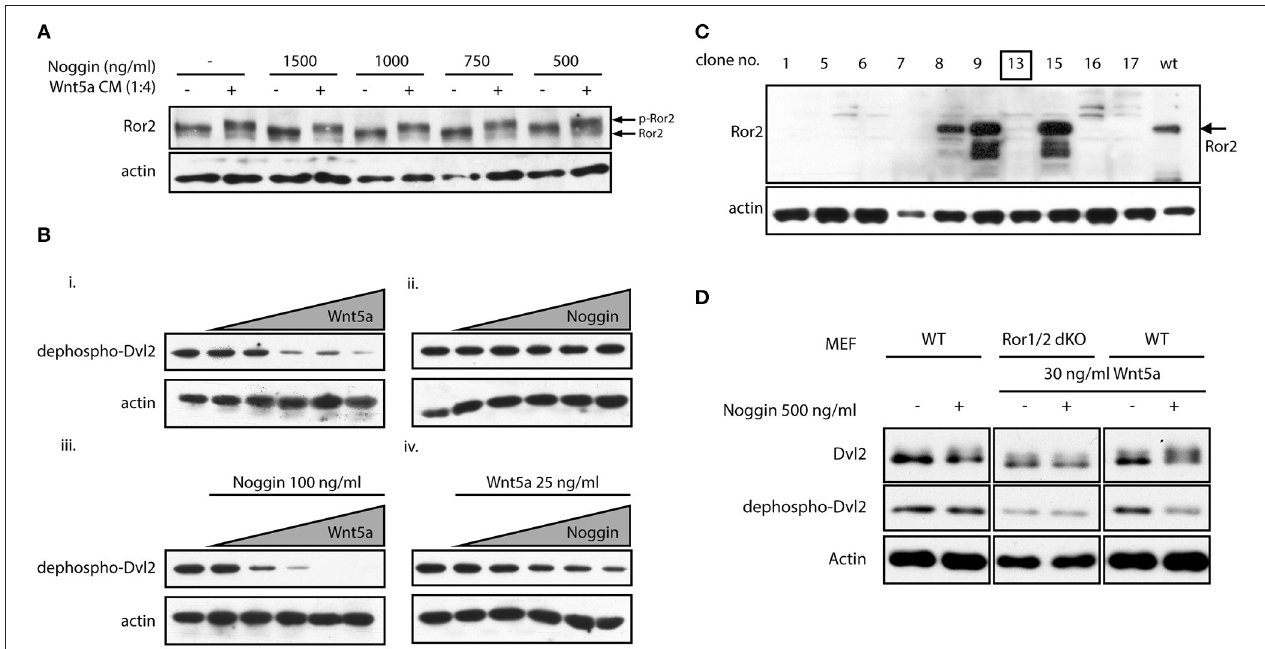
FIGURE 2 | Noggin potentiates Wnt/PCP signaling. (A) MEF cells were treated by Wnt-5a conditioned medium (CM) and stimulated by increasing doses of Noggin protein. Activation of Ror2 was analyzed as a phosphorylation-dependent shift by Western blotting. Noggin alone, in contrast to Wnt-5a CM, is not able to trigger activation of Ror2. (B) MEF cells were treated with increasing doses of Wnt-5a (0, 25, 50, 100, 150, and 200 ng/ml) and Noggin (0, 25, 50, 100, 150, and 200 ng/ml) for 2 h. The activation of Wnt signaling was assessed by Western blotting as a decrease in the signal of dephospho-Dvl2. Wnt-5a could cause phosphorylation of Dvl2 visible as a disappearance of dephospho-Dvl2 signal (i) , whereas Noggin is inactive in the same assay (ii) . Interestingly, pre-treatment of MEF cells by Noggin (100 ng/ml) enhanced the effect of Wnt-5a (iii) . On the other hand, Noggin, in a dose-dependent manner, potentiated the response to suboptimal doses of Wnt-5a (25 ng/ml), which are otherwise ineffective—see lane 2 in panel “i” (iv) . Actin is used as a loading control. (C) Ror1 flox / flox ; Ror2 flox / flox MEF cells were treated by tamoxifen and Ror1 − / − ; Ror2 − / − isogenic MEF line was isolated by serial dilutions method. The presence of Ror2 was tested by Western blotting and the clone no. 13 used for further studies is indicated. (D) MEF wt and MEF Ror1 − / − ; Ror2 − / − (Ror1/2 dKO) cells were treated by combinations of Noggin and Wnt-5a as indicated. Noggin itself cannot stimulate activation of Dvl2—visible as a phosphorylation-dependent shift of Dvl2 (upper blots) or decrease in dephospho-Dvl2